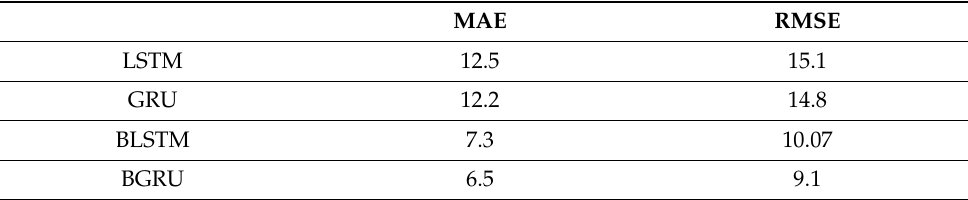
Table 4. Results of each model with respect to categorical accuracy.